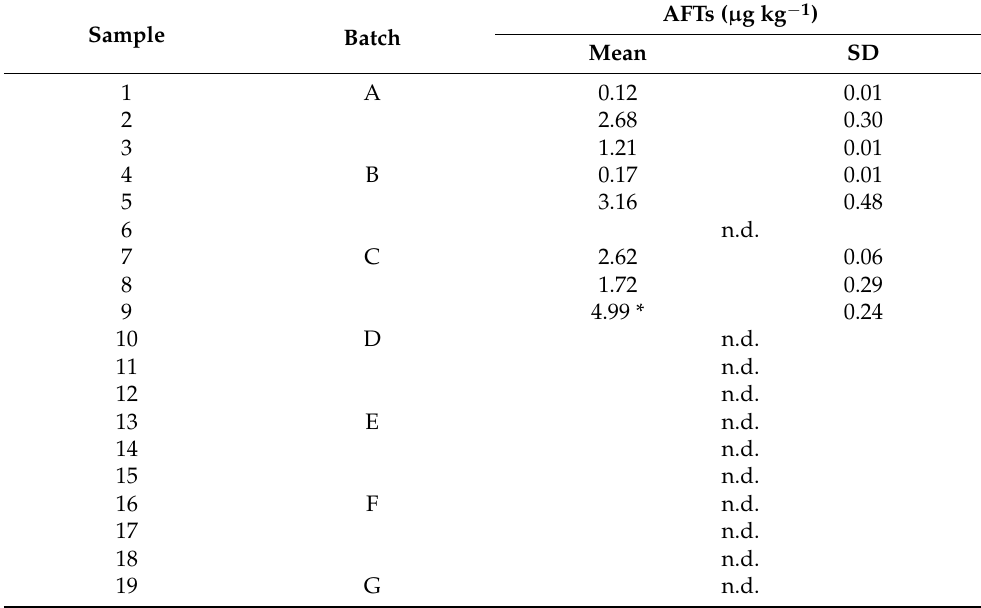
Table 5. Concentration of Aflatoxins (AFTs, expressed as the sum of B1, B2, G1 and G2 AFTs, µ g kg − 1 DW) for sample. Values are given as samples mean ± SD (standard deviation, n = 3); if concentration was below the method detection limit, values were reported as n.d. = not detected. * Values higher than that allowed by Commission Regulation (EC) No 1881/2006 of 19 December 2006, setting maximum levels for certain contaminants in foodstuffs (http://data.europa.eu/eli/reg/2006/1881/ 2022-01-01, accessed on 1 December 2022).